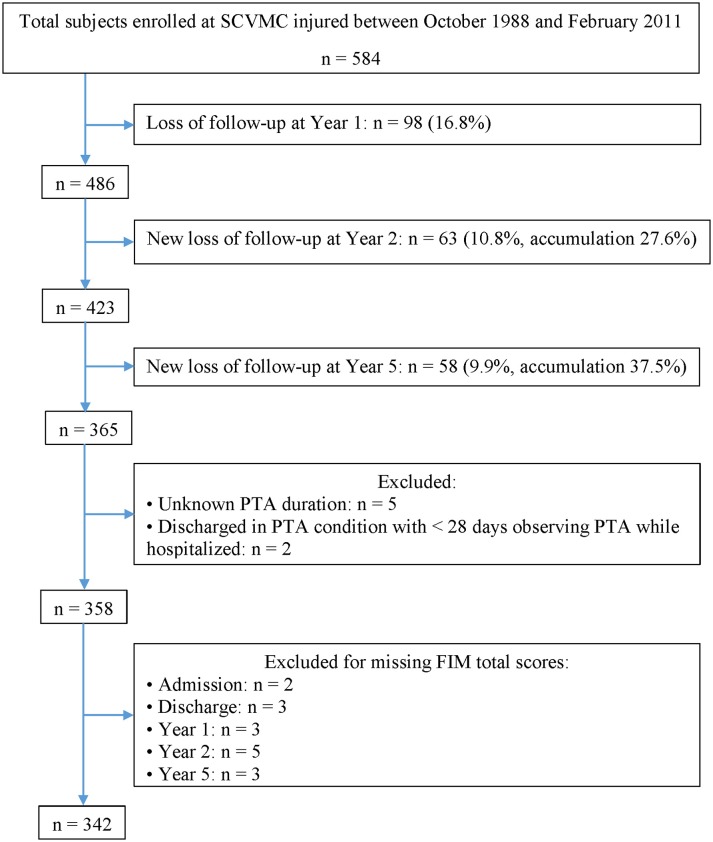
Flowchart of the study participants.